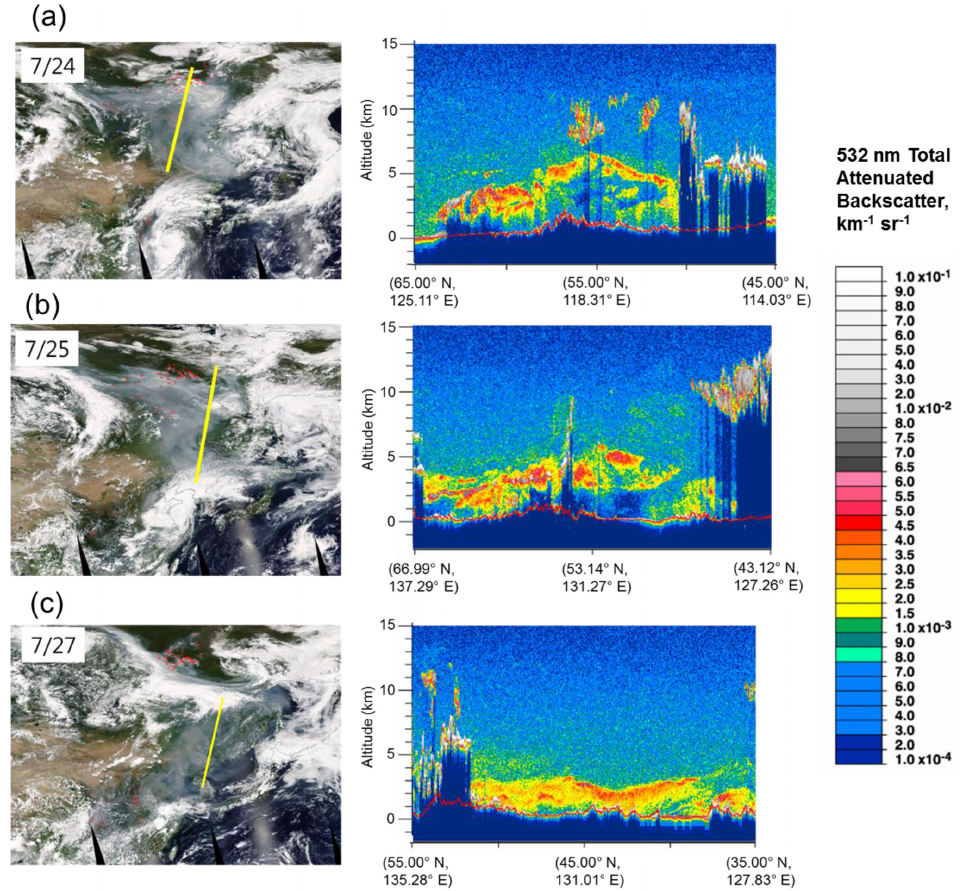
Figure 6. MODIS RGB images and vertical profiles of total attenuated backscatter at 532nm measured by the CALIPSO satellite during (a) 24, (b) 25, and (c) 27 July 2014. Yellow lines in the MODIS RGB images indicate the route of the CALIPSO satellite, and correspond to the x axis in the vertical profiles of total attenuated backscatter.